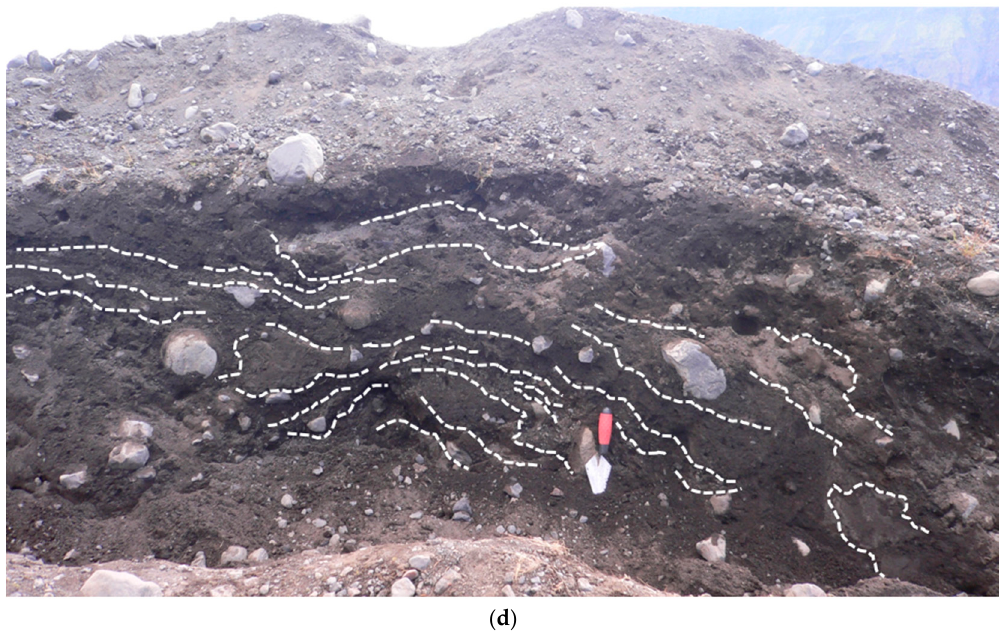
Figure 7. The outermost moraines on the glacier forelands: ( a ) Aerial photograph extract (NERC ARSF 2007) of the outermost moraines on the Sandfellsjökull foreland. Crenulate recessional push moraines are superimposed on glacially overridden (fluted) moraines; ( b ) The closely spaced and locally superimposed, post-1930 push moraines on the north Sandfellsjökull foreland (ice flow was from right to left); ( c ) The outermost moraines of the Oldufellsjökull foreland, showing the three main moraine ridges and their subsidiary minor, locally superimposed ridges; and, ( d ) A section through one of the outer Sandfellsjökull moraines, with annotations showing the major boundaries between sedimentary facies of poorly-sorted sand and gravel lenses overlain by sand and gravel rich diamictons.